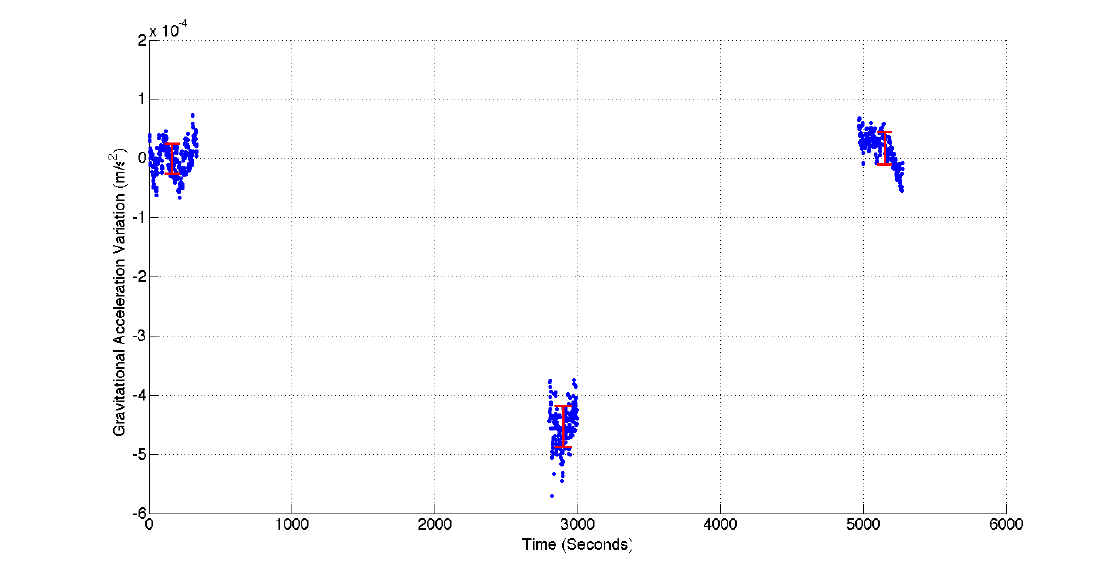
Figure 7. An image of the gravity measurement being conducted at the top of the hill. The user can be seen levelling the platform before the data is recorded.